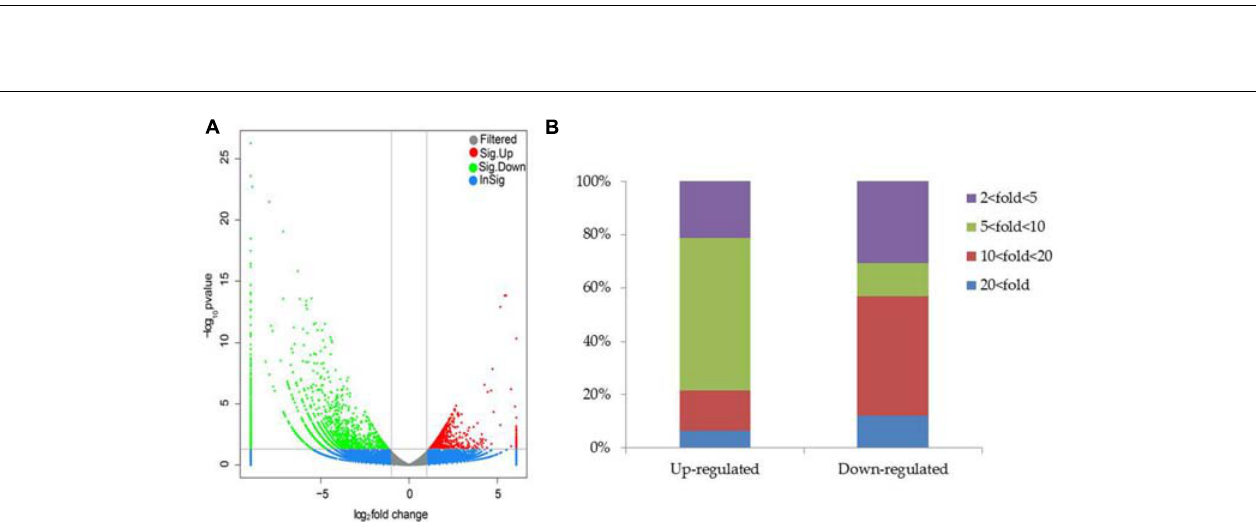
FIGURE 6 | Distribution of differentially expressed genes between the non-inoculated (NI) and inoculated (I) libraries. (A) Scatter plot of gene expression difference. Green and red dots indicate up- and down-regulated genes under saline–alkaline stress, respectively. Blue dots indicate genes without significant differential expression, and gray dots indicate genes that were filtered out low quality reads. (B) Statistics of DEGs. Different color column indicated DEGs with diverse fold changes.